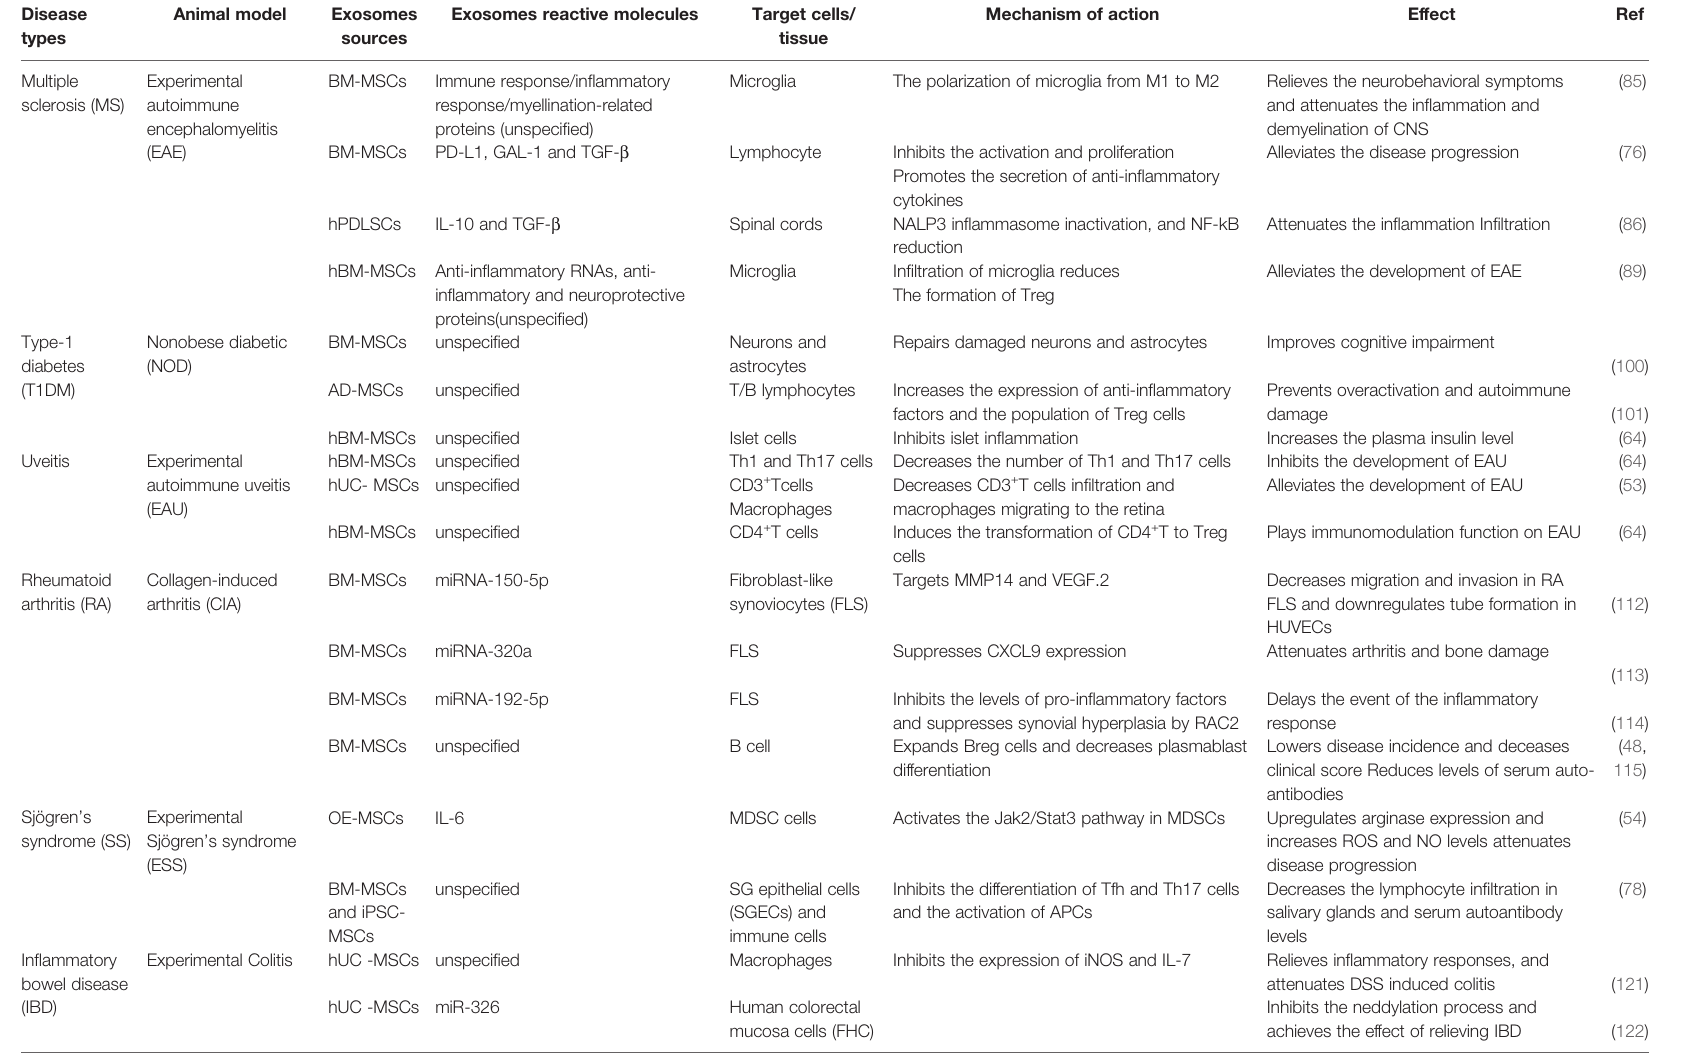
TABLE 1 | The role of MSC-EVs in the treatment of autoimmune diseases, as discussed in the